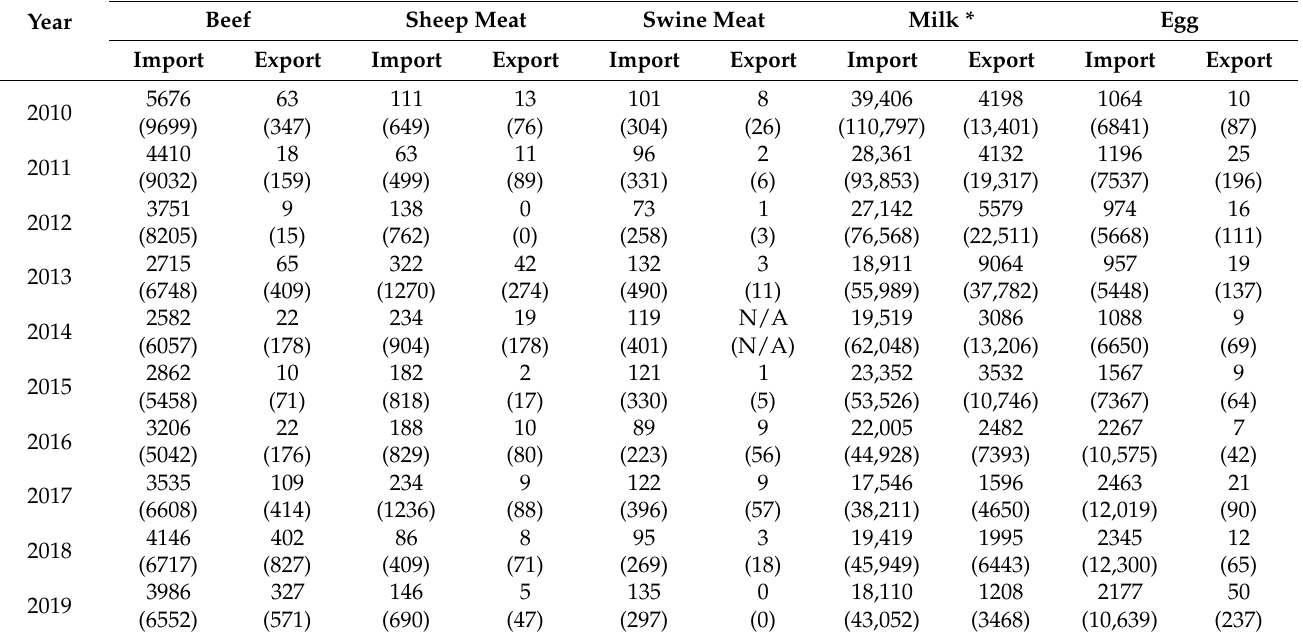
Table 1. Quantities and values of key livestock products traded in Senegal during the period of 2010–2019.